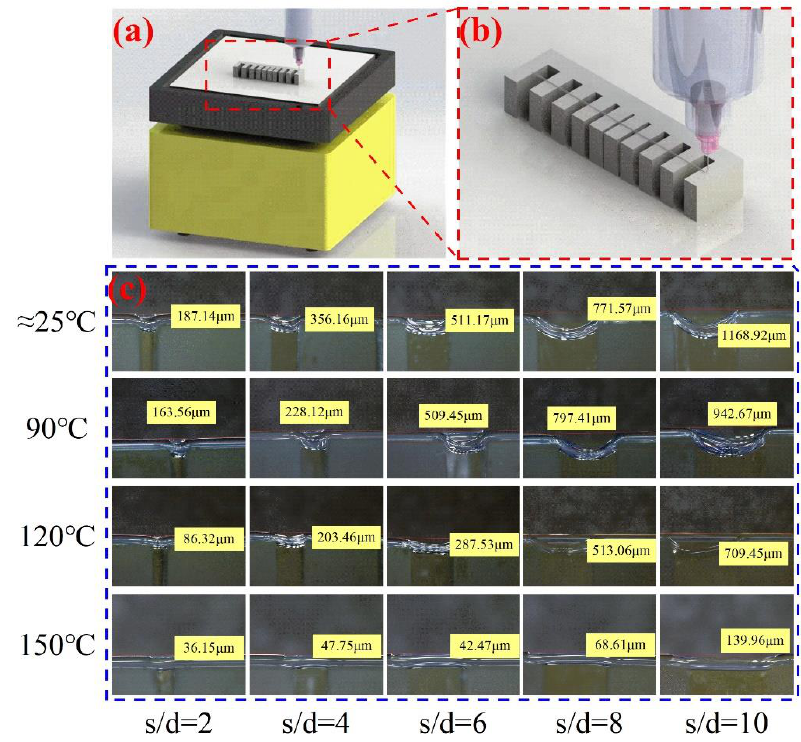
Figure 8. Experiment on the collapse of silicone rubber filaments: ( a ) schematic illustration of experimental equipment; ( b ) bracket with different gaps formed by digital light process (DLP); ( c ) characterization of silicone rubber filament collapse.